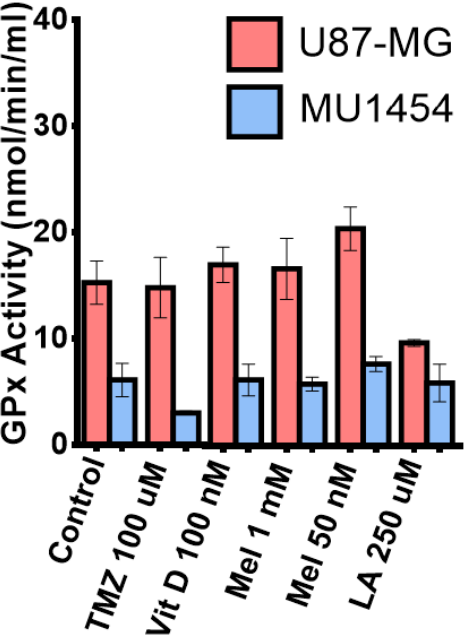
Figure 6. Measurement of Glutathione Peroxidase 1 (GP×1) activity in U87 ‐ MG and MU1454 after treatment with antioxidants (Vitamin D [Vit D], Lipoic acid [LA], or melatonin [Mel]) or Temozolomide (TMZ).